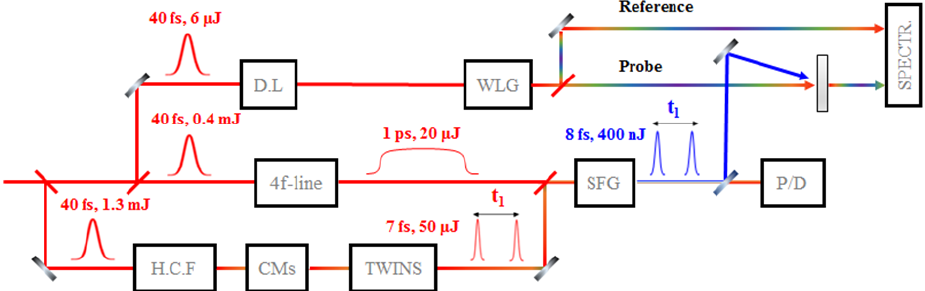
Fig. 1. Layout of the experimental setup (H.C.F.: hollow-core fiber, CMs: Chirped Mirrors, D.L: Delay line, WLG: White Light Generation, P/D: Photodiode, SPECTR: Prism spectrometer equipped with two linear CCD